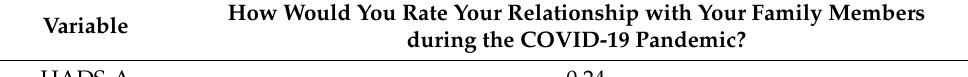
Table 5. Correlations between HADS and GAD-7 scales indications and relationship assessment with